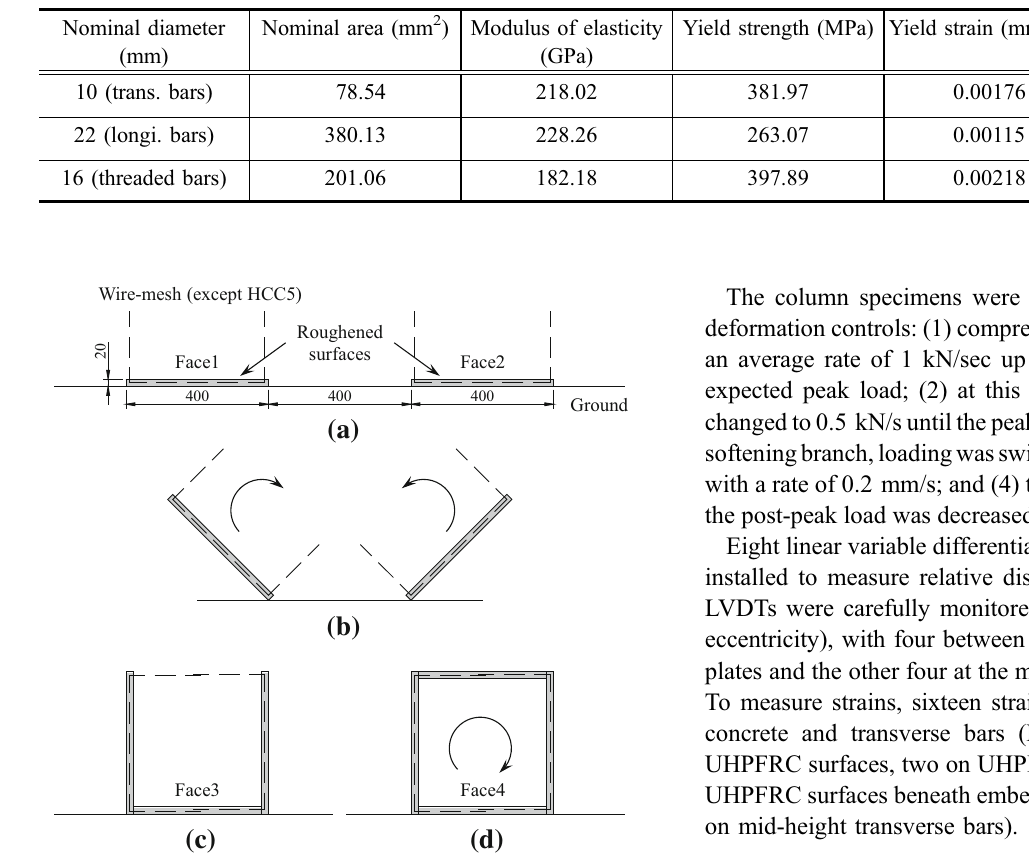
Table 3 Measured mechanical properties of